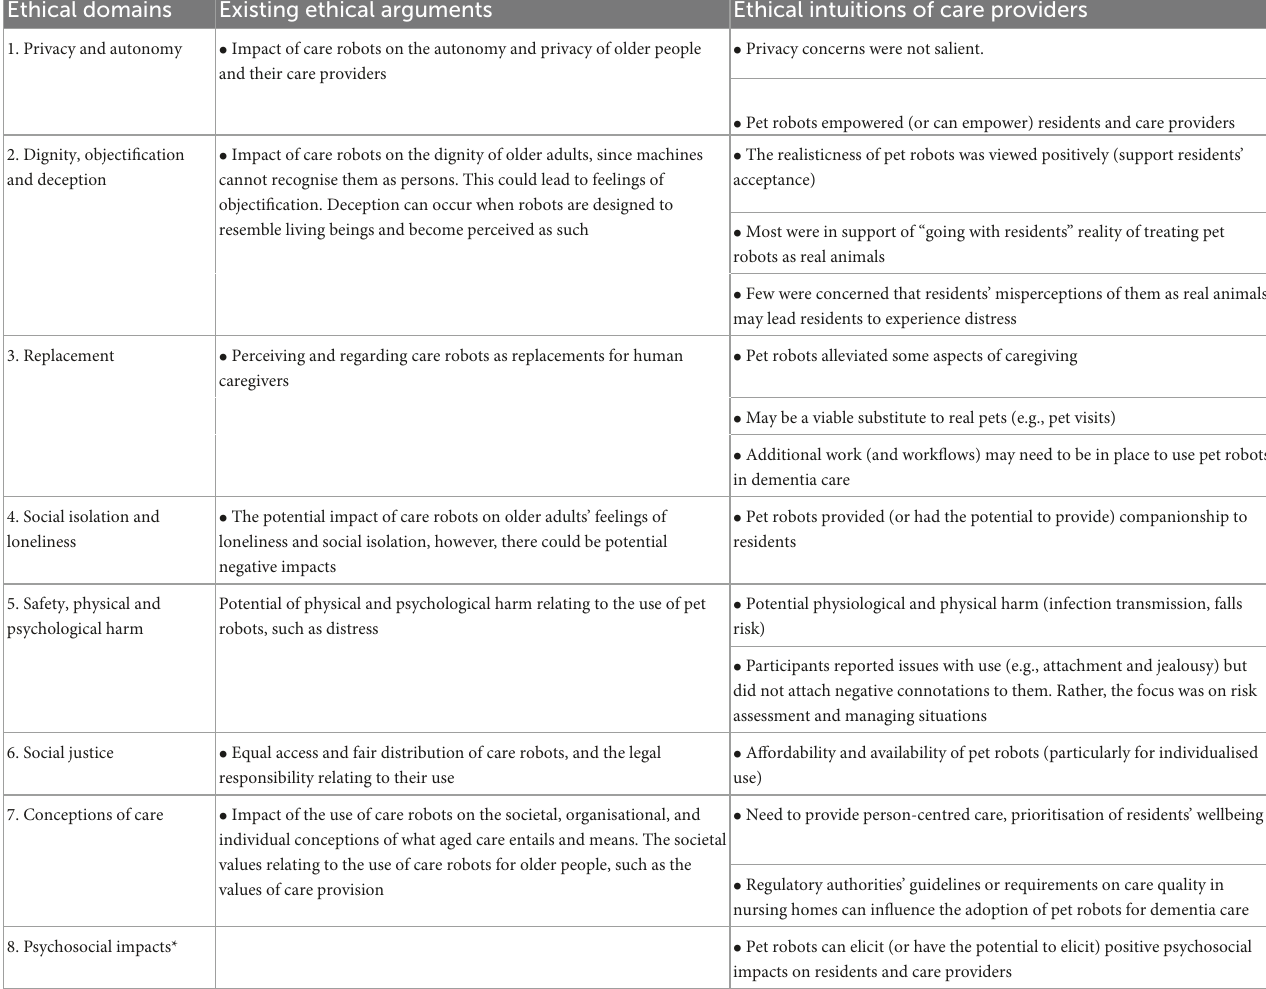
TABLE 4 Comparing ethical arguments with participants’ ethical